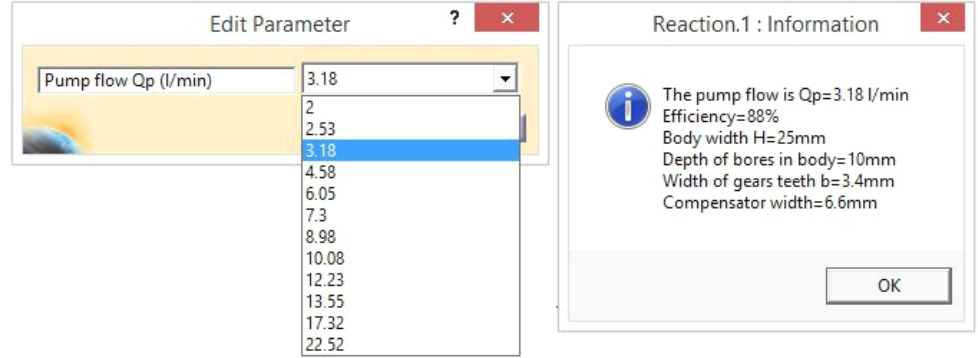
Figure 3. Selection of pump’s flow rate and confirmation of modified values through parametric design.